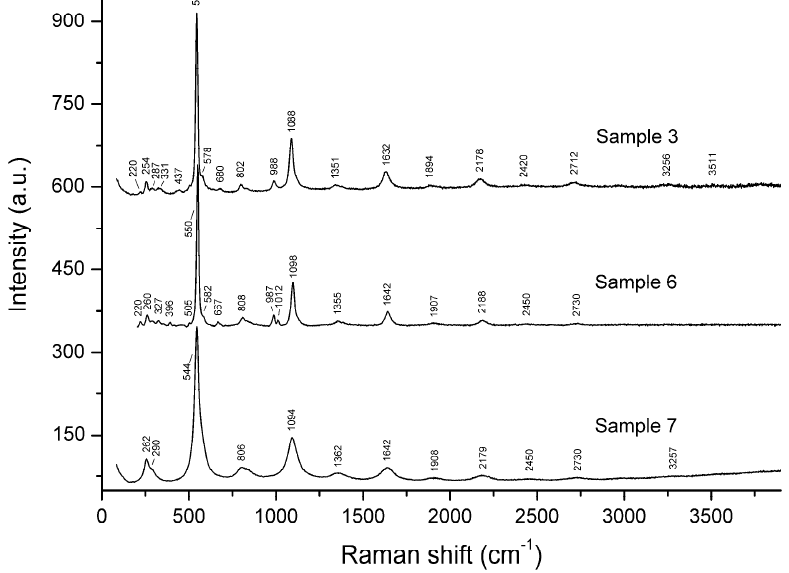
Figure 10. Raman spectra of the members of the haüyne–lazurite solid-solution series.